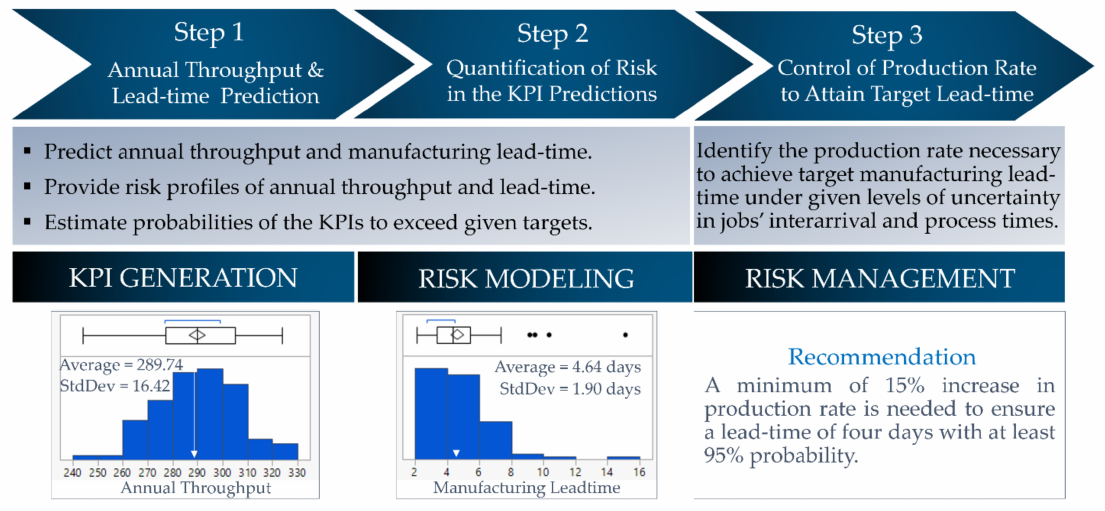
Figure 8. Connecting case objectives to digital twin simulation